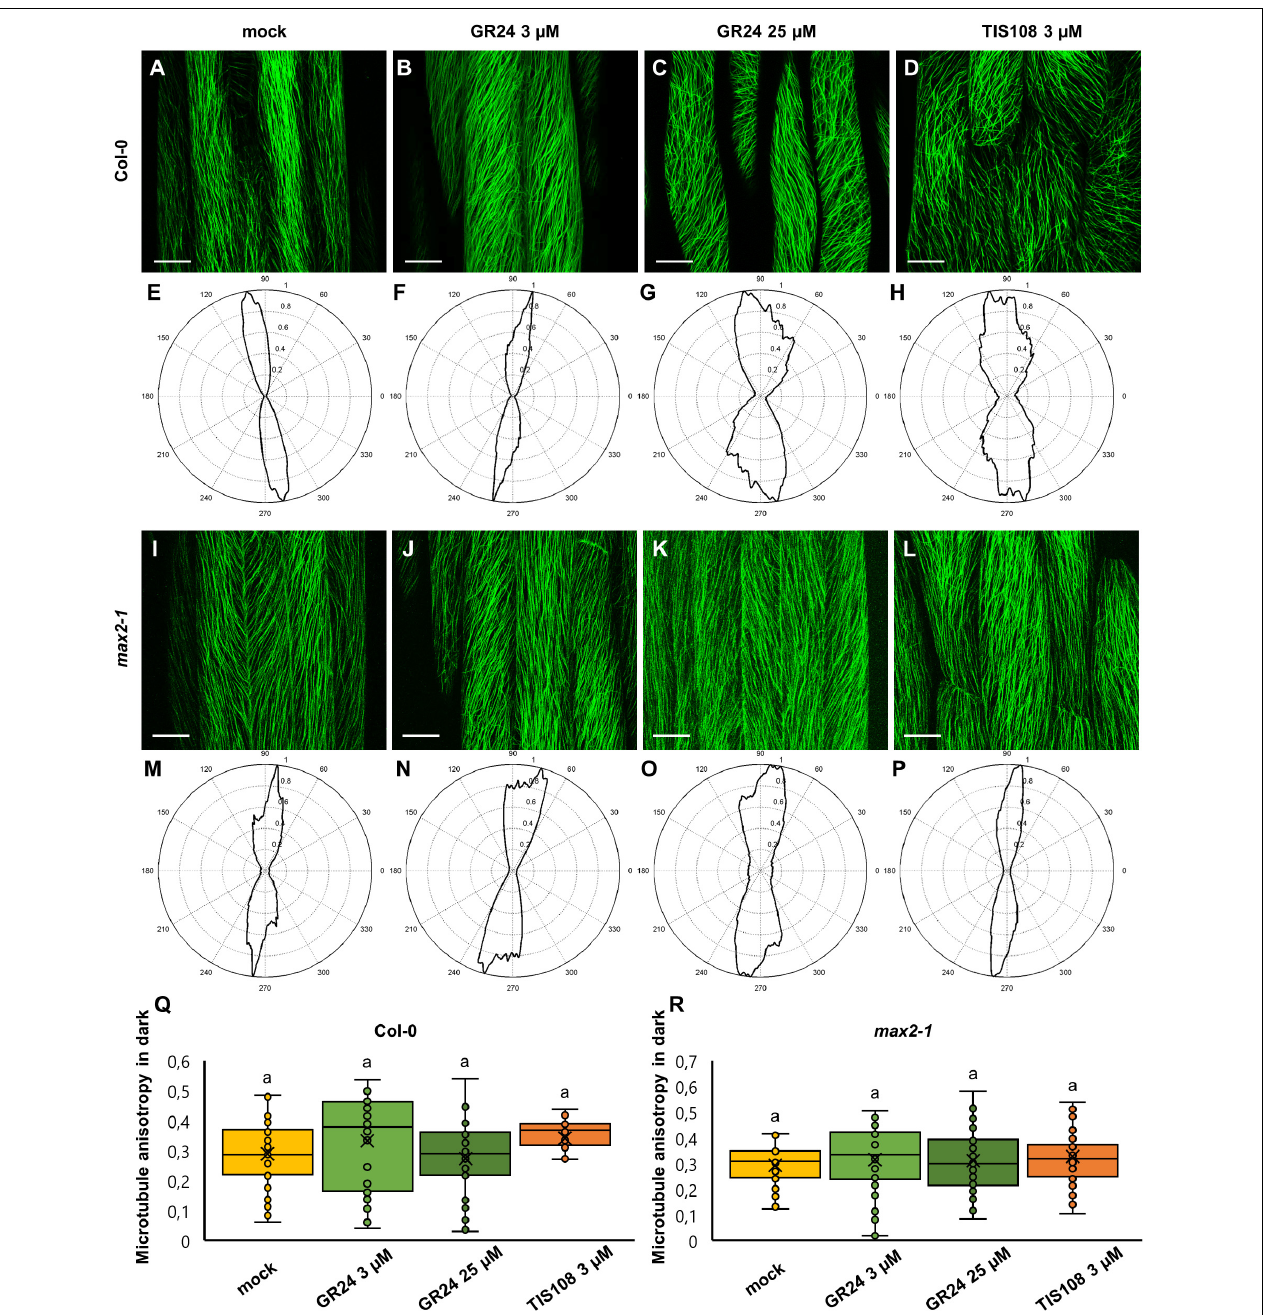
FIGURE 4 | Assessment of microtubule organization in epidermal hypocotyl cells of etiolated seedlings of Arabidopsis Col-0 or the max2-1 mutant expressing GFP-MBD construct in the presence or the synthetic strigolactone GR24 (3 µ M and 25 µ M) or the biosynthetic inhibitor of strigolactone production TIS108 (3 µ M ). (A–D) Overview of hypocotyl of Col-0 seedlings treated with mock (A) , 3 µ M GR24 (B) , 25 µ M GR24 (C) , 3 µ M TIS108 (D) . (E–H) Cytospectre graphs of cortical microtubule distribution where panel (E) corresponds to panel (A) , panel (F) to panel (B) , panel (G) to panel (C) , and panel (H) to panel (D) . (I–L) Overview of hypocotyl of max2-1 seedlings treated with mock (I) , 3 µ M GR24 (J) , 25 µ M GR24 (K) , 3 µ M TIS108 (L) . (M–P) Cytospectre graphs of cortical microtubule distribution, where panel (M) corresponds to panel (I) , panel (N) to panel (J) , panel (O) to panel (K) , and panel (P) to panel (L) . (Q) Quantitative assessment of anisotropy of cortical microtubule organization in etiolated Col-0 after mock treatment and treatments with 3 µ M GR24, 25 µ M GR24, and 3 µ M TIS108 ( N ≥ 27; Welch’s ANOVA showed no statistically significant difference within the dataset; F (3, 143) = 3.1416, p = 0.030. (R) Quantitative assessment of anisotropy of cortical microtubule organization in etiolated max2-1 after mock treatment and treatments with 3 µ M GR24, 25 µ M GR24, and 3 µ M TIS108 ( N ≥ 29; Welch’s ANOVA was followed with Scheffé’s test, but there was no statistically significant difference at the 0.01 probability level; results are in Supplementary Table 6 ). In all box plots, the average is presented by × , median by the middle line, 1 st quartile by the bottom line, 3 rd quartile by the top line; the whiskers lie within the 1.5 × interquartile range (defined from the 1 st to the 3 rd quartiles) while outliers are omitted. Scale bars: 20 µ m.